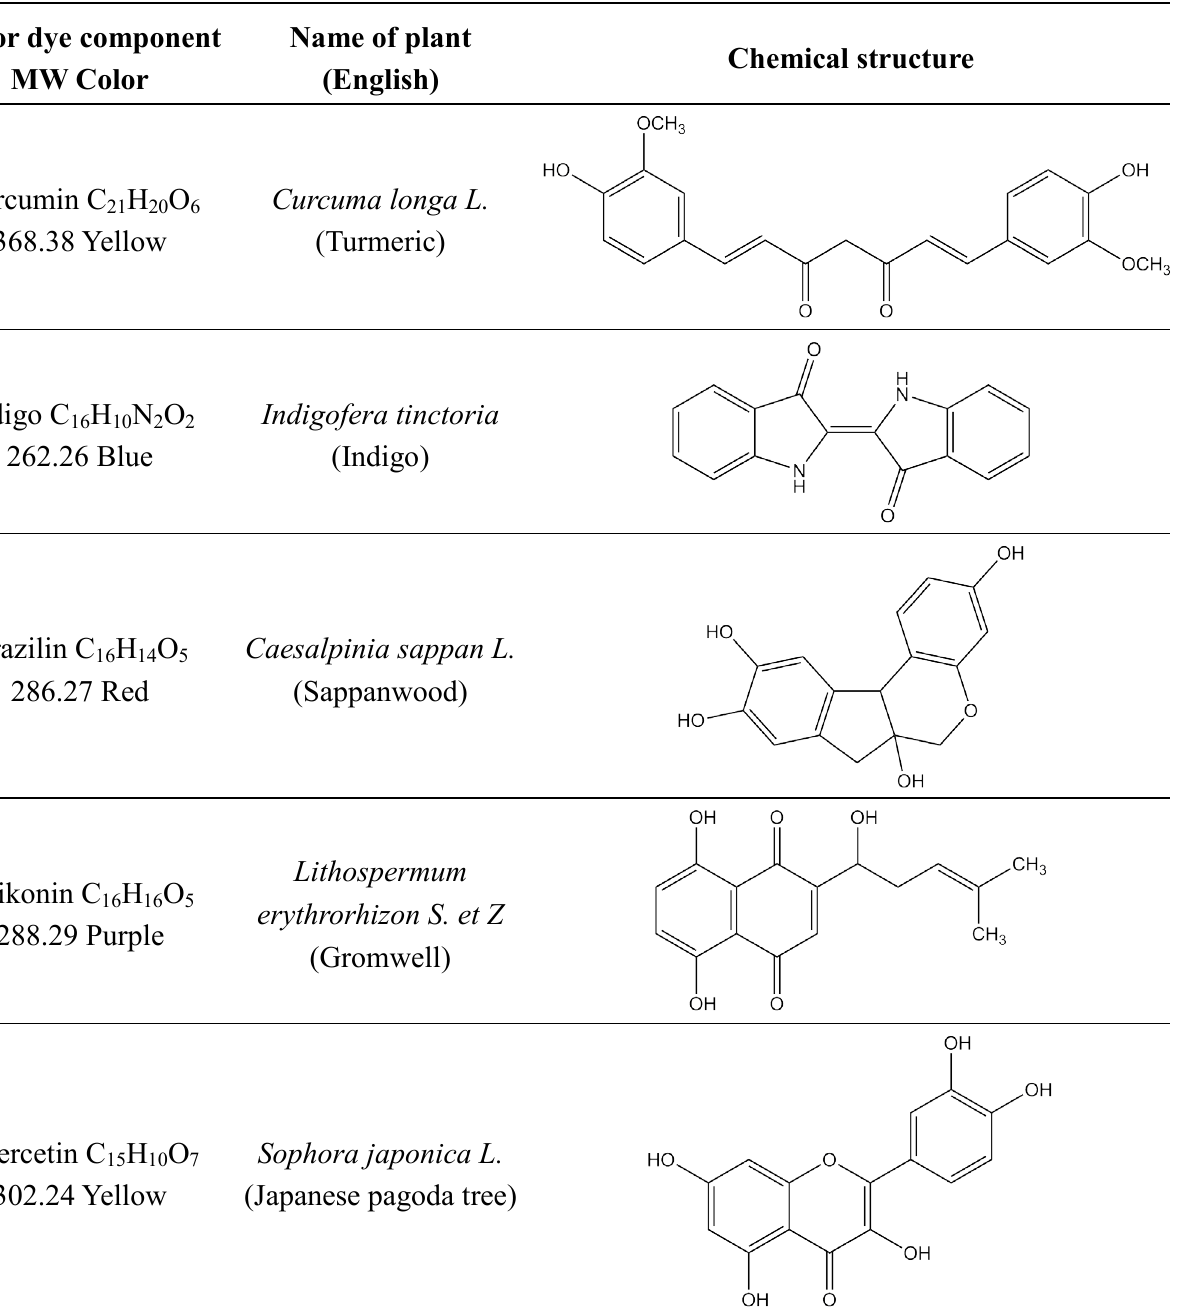
Table 1. Details of the natural dyes extracted from